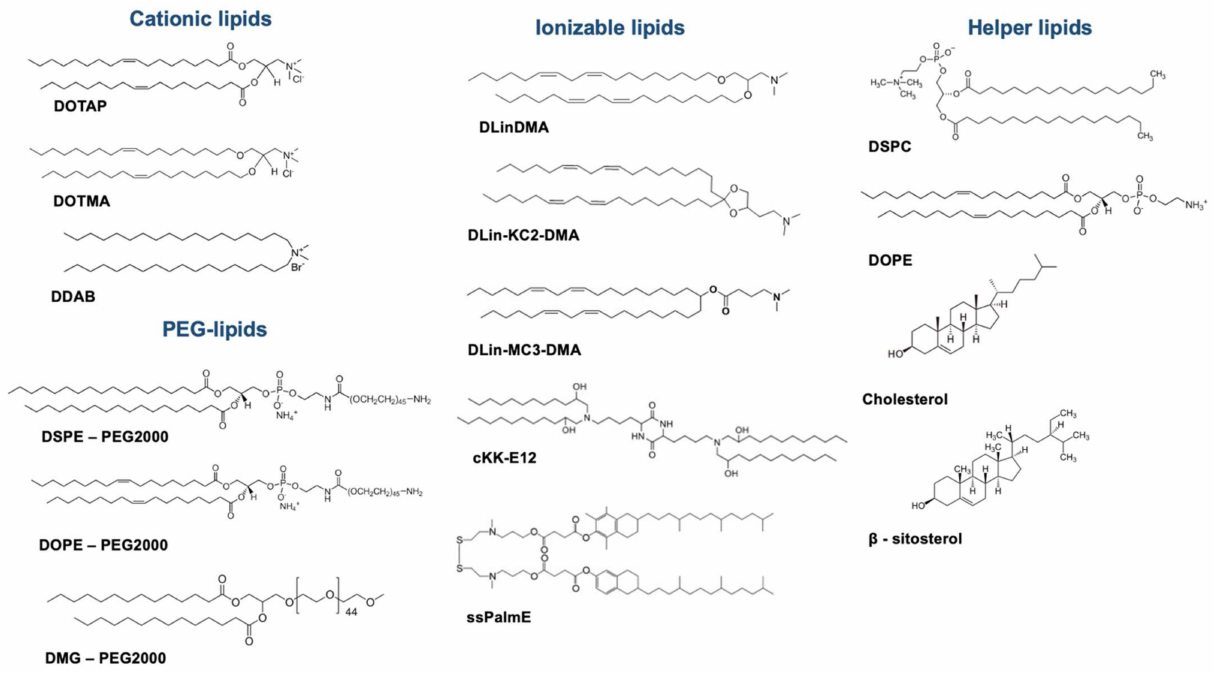
Figure 2. Chemical structure of some LNPs’